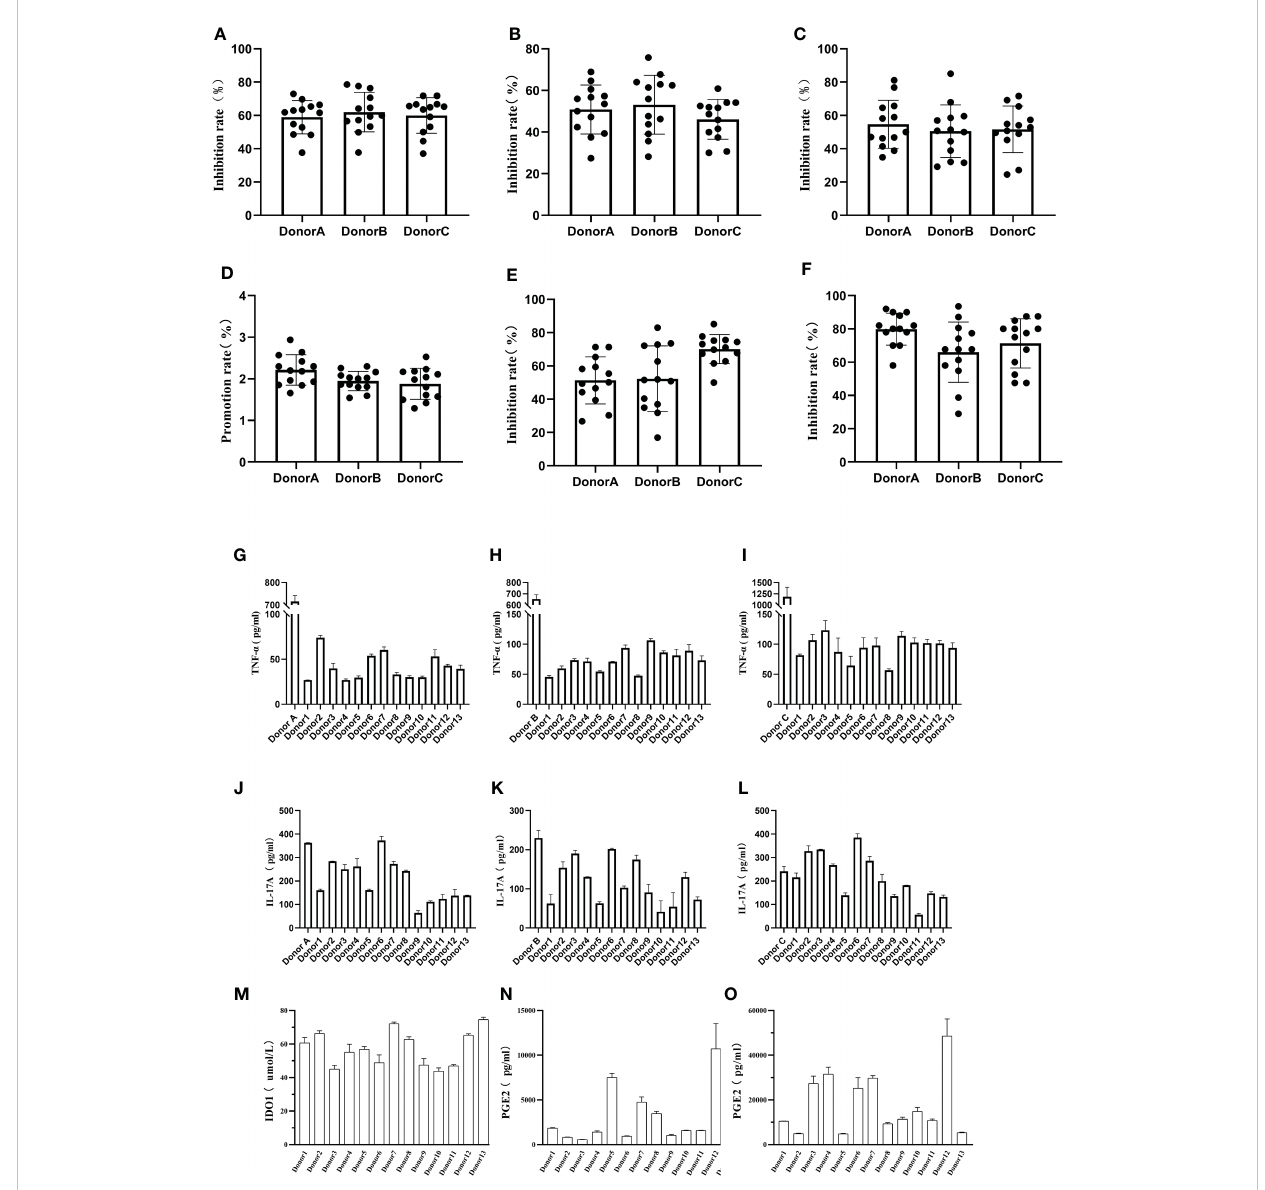
FIGURE 4 Detection of hUCMSCs immune regulation function. (A – C) : The effect of co-culturing hUCMSCs and PBMCs on the suppression function of PBMCs, CD3+ T cells, and CD4+ T cells; (D – F) : The effect of co-culturing MSCs and PBMCs on T-reg, Th1 and Th17 cells; (G – I) : Secretion levels of TNF- a after co-culturing hUCMSCs with PBMCs (Donor A, Donor B, Donor C), and the control group was PBMCs added with PHA; (J – L) : Secretion levels of IL-17A after co-culturing hUCMSCs with PBMCs (Donor A, Donor B, Donor C); (M, N) : The secretion levels of IDO1 and PGE2 in the culture medium after hUCMSCs were cultured for 24 hours; (O) : The secretion levels of PGE2 in the culture medium after hUCMSCs were cultured for 24 hours under the stimulation of TNF- a (500IU/ml) and IFN- g (1000IU/ml). Proliferation rate = PBMC+PHA+MSC group/PBMC+PHA group-1; and the inhibition rate = (1-PBMC+PHA+MSC group/PBMC+PHA group) * 100%. PBMC : MSC =10:1, and 10ng/ml PHA was